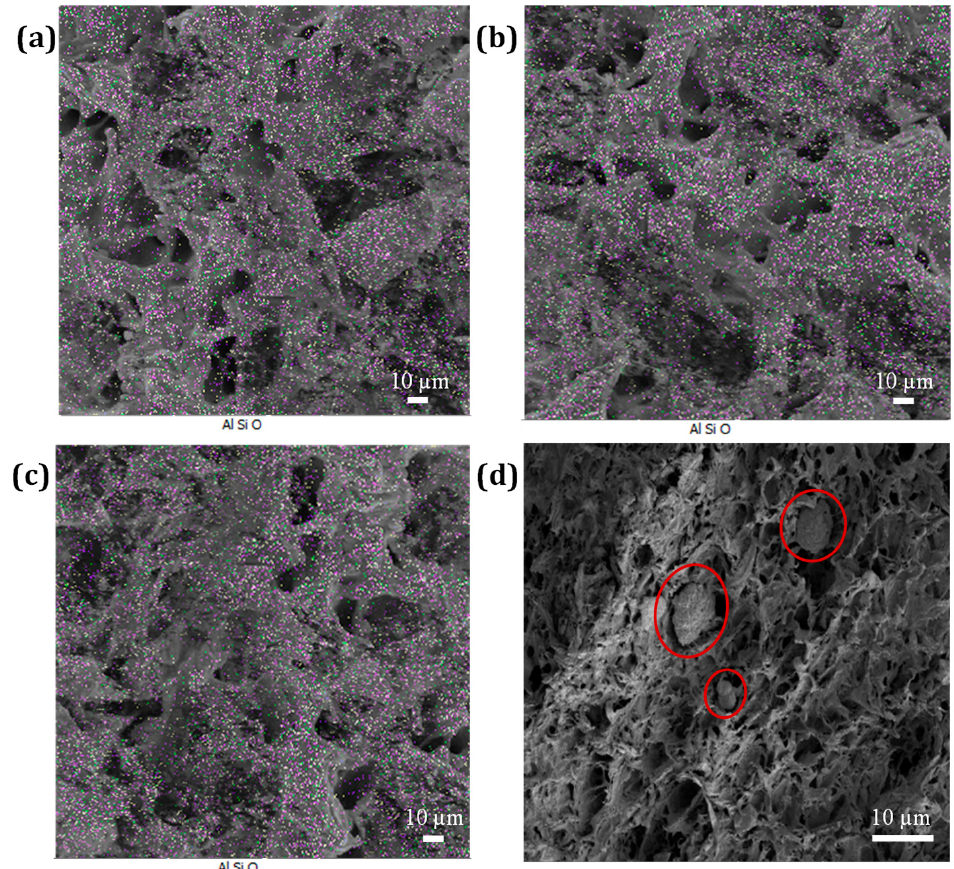
Figure 7. EDX maps of impact-fractured specimens of PP/NBR blends filled with different fractions of ( a ) 3 wt.%, ( b ) 5 wt.%, and ( c ) 7 wt.% HNTs and ( d ) agglomerate (7 wt.% HNTs).